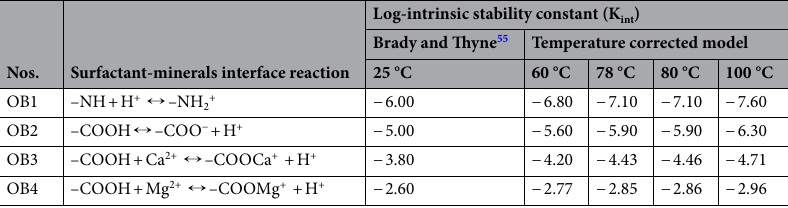
Table 9. Surface complexation reactions with intrinsic stability constants at the oil-brine interface.